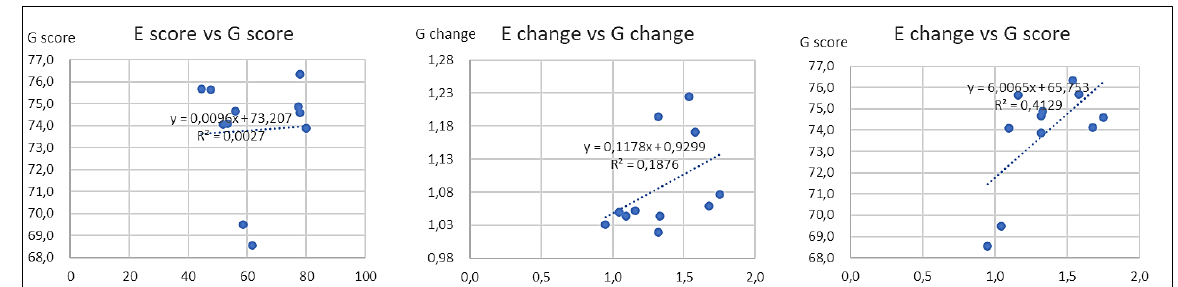
Figure 5. S&P Sector Dependencies